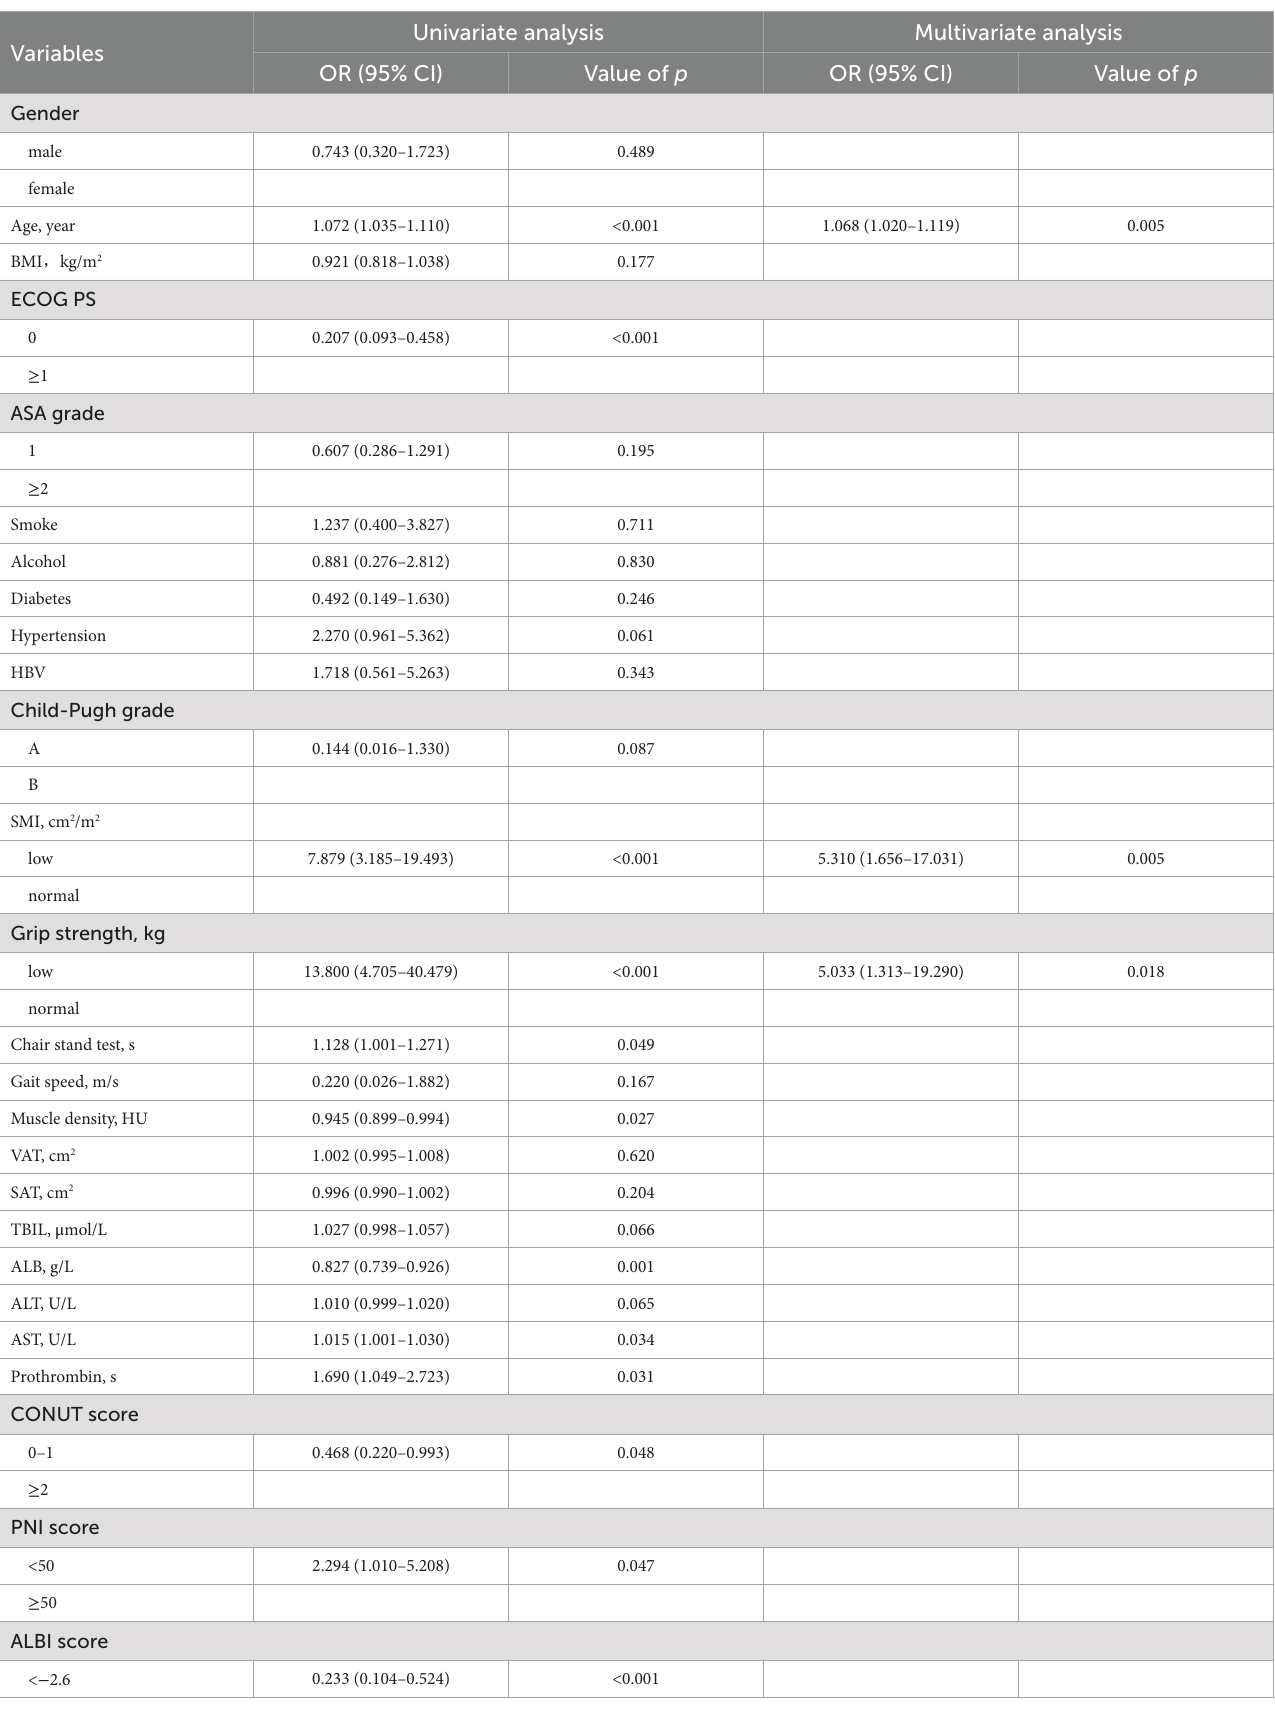
TABLE 2 Univariate and multivariate logistic regression analysis of predictors of overall complications. Univariate analysis Multivariate Variables